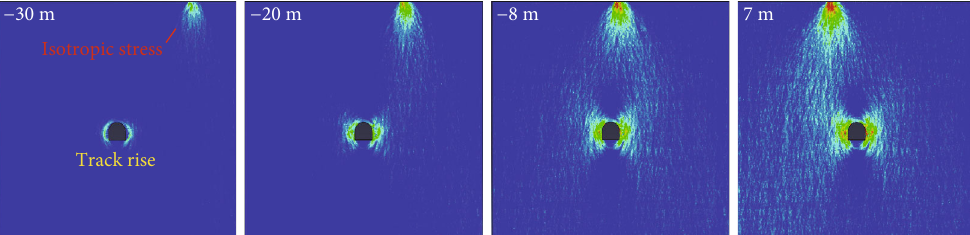
Figure 8: The variation pattern of the equivalent stress with the advance of the working face.